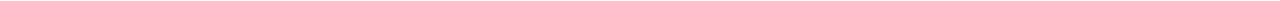
Fig. 3 MafB directly regulates C1qa , C1qb , C1qc genes. a Half of the Maf recognition elements (half-MARE) were identi fi ed in C1q gene promoters using the UCSC Genome Browser. The half-MARE site in the C1q gene promoters (bold) was highly conserved among mammalian species. b Half-MARE was also conserved in zebra fi sh. c A MafB-expressing vector was co-transfected with luciferase reporter constructs of C1qa , C1qb , or C1qc promoter containing a MARE site or a mutant MARE site into RAW264.7 cells. The luciferase activity was analyzed after a 24 h transfection. The term “ mut ” indicates mutation in the MARE sites. Data are presented as the means ± s.e.m. of duplicates. The data are from one experiment that is representative of at least two independent experiments. d A ChIP assay was conducted using RAW264.7 cells. Flag-mock and Flag-MafB-expressing vectors were transfected into the cells. After 24 h, chromatin from the transfected cells was precipitated with anti-Flag and anti-IgG. The half-MARE sequences in the C1q gene promoters were ampli fi ed and analyzed by qPCR. The data are from one experiment that was representative of at two independent experiments. e A ChIP assay was conducted using THP-1 cells. The cells were collected after they were treated with or without dexamethasone (Dex) and IFN γ , and then chromatin was precipitated with anti-MAFB and anti-IgG. The half-MARE sequences in the C1q gene promoters were ampli fi ed and analyzed by qPCR. The data are from one experiment that was representative of two independent